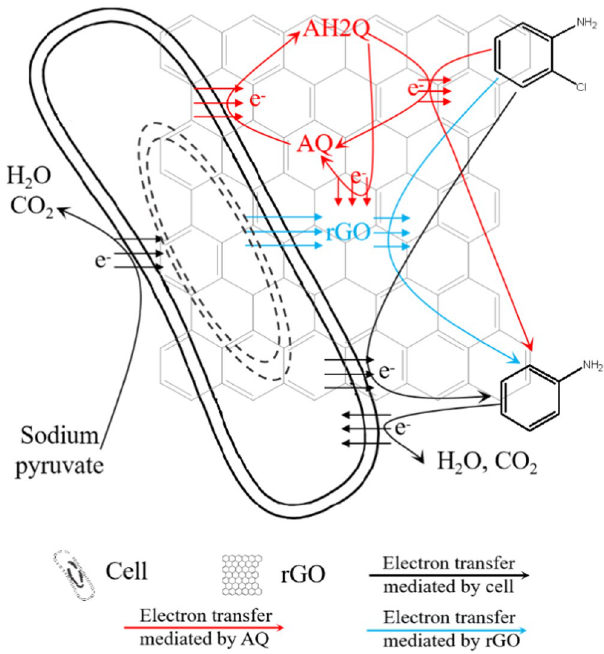
Figure 5. Electron transfer pathways of AQ-GO-mediated 2-CA degradation were